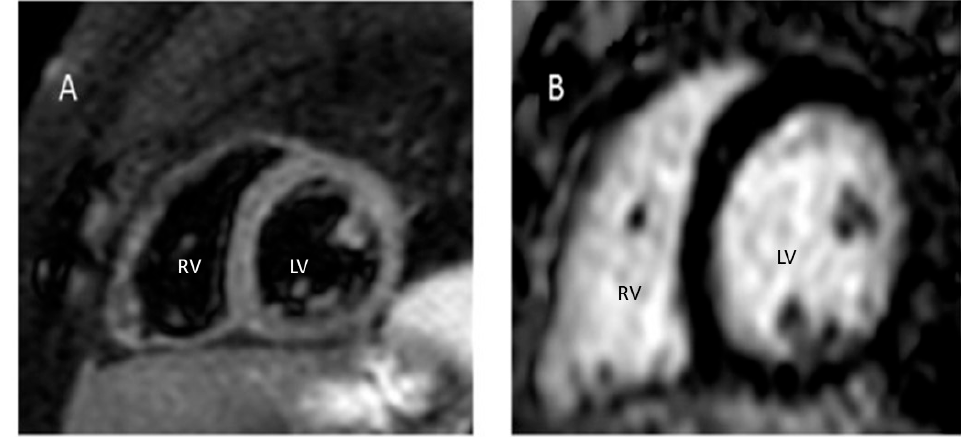
Figure 3. Short-axis T2-weighted image through the left ventricle base showing no early ( A ) or late-gadolinium enhancement ( B ).